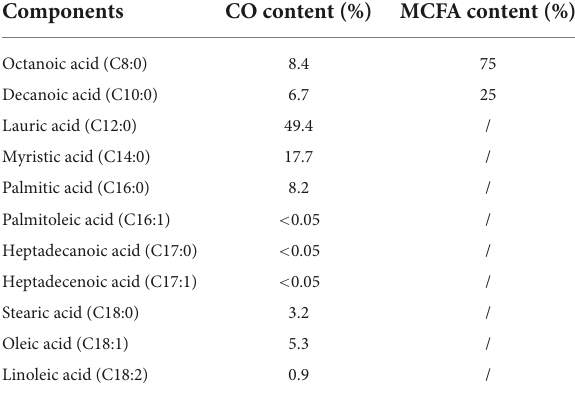
TABLE 2 The quantity contents (%) of the component in sample CO and